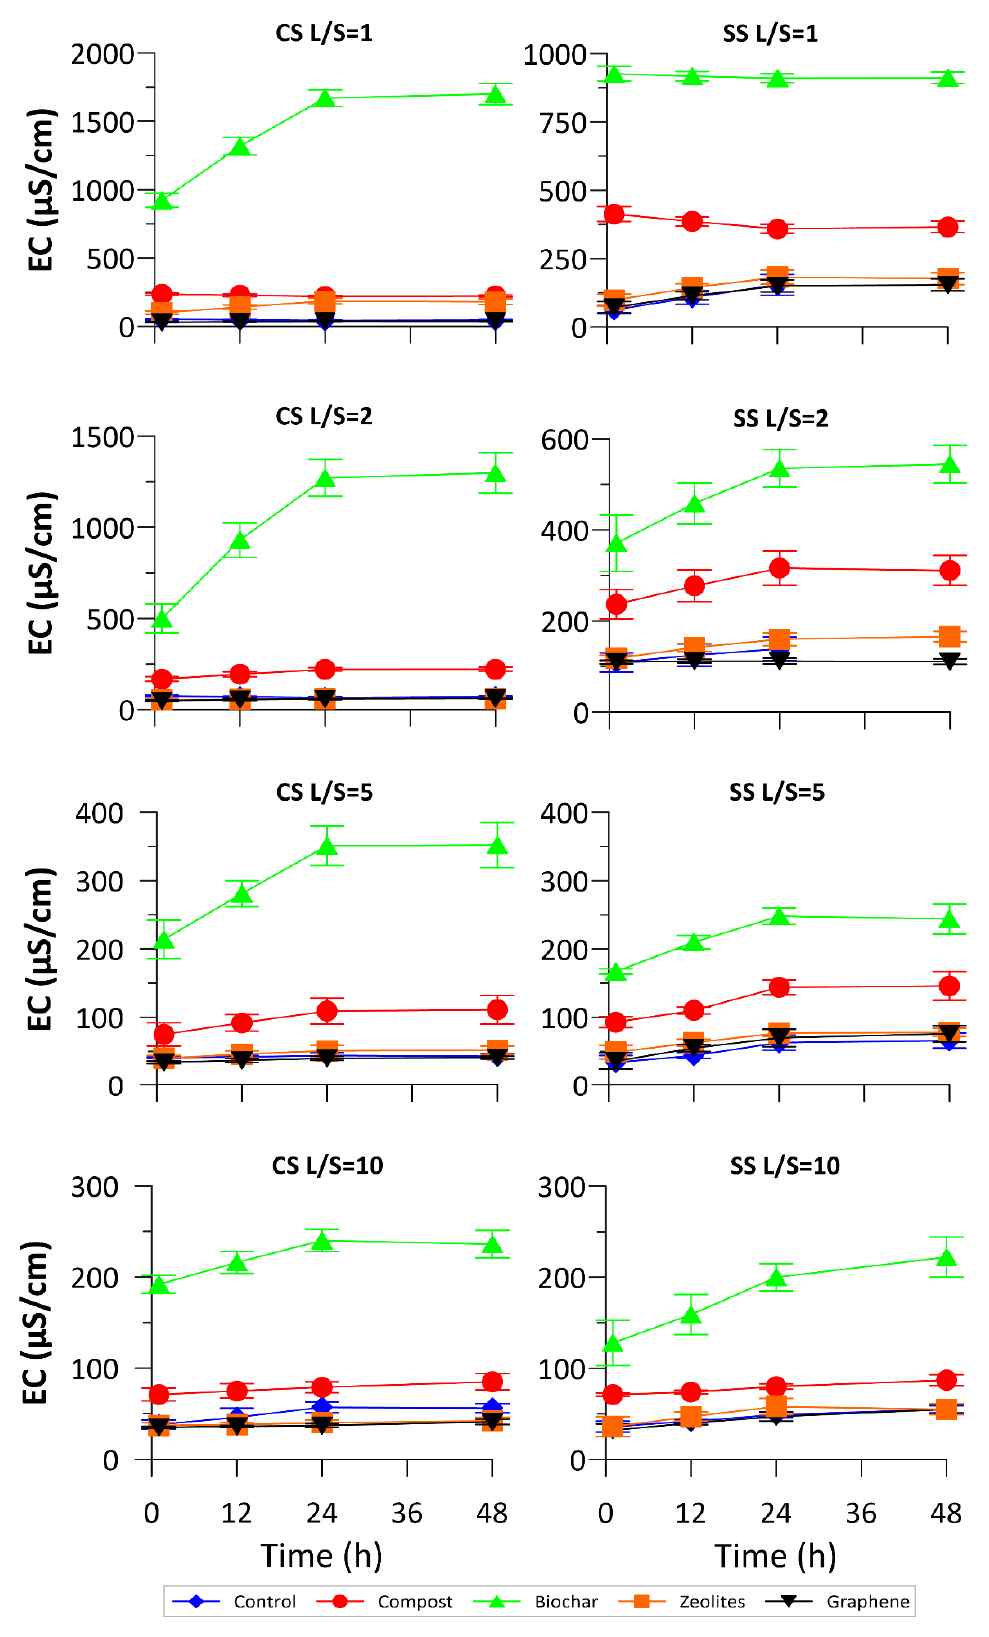
Figure 1. EC trends in SSE batches experiments with CS ( left panels ) and SS ( right panels ) for dif- ferent L/S ratios. Error bars denote standard deviation calculated on three replicas.